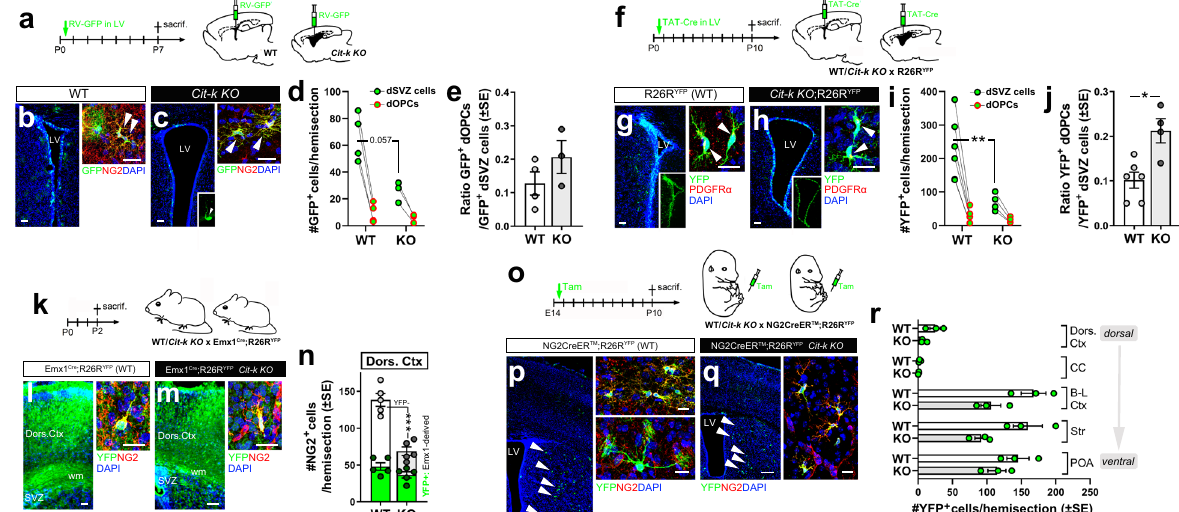
Fig. 3 Lineage-tracing approaches show that dorsal oligodendrogenesis is preserved in Cit-k KO mouse forebrain. a RV-based lineage-tracing approach. b , c ) Oligodendroglial cells (NG2 + , red) in P7 WT ( b right) or Cit-k KO ( c right) mouse dorsal cortices derived from VZ/SVZ precursors (GFP + , green) targeted by the RV ( b left, c left). White arrowheads in b right and c right indicate NG2 + OPCs. d Absolute numbers/hemisection of RV-targeted (GFP + ) cells in the dorsal SVZ (dSVZ; WT n = 4, KO n = 3; two-tailed Mann – Whitney U-test, P = 0.057) and of their OPC (GFP + /NG2 + ) progeny in the dorsal cortex (dOPCs; WT n = 4, KO n = 3; two-tailed Mann – Whitney U-test, n.s.). e Ratio between the number of GFP + /NG2 + cells in the dorsal cortex (dOPCs) and the number GFP + dSVZ precursors/hemisection (WT n = 4, KO n = 3; two-tailed Mann – Whitney U-test, n.s.). f TAT-Cre-based lineage- tracing approach. ( g left, h left) Recombined (YFP + , green) VZ/SVZ precursors in WT (R26R YFP ; g left) and Cit-k KO ( Cit-k KO; R26R YFP ; h left) mice. ( g right, h right) OPC (PDGFR α + , red) progeny (YFP + , green) in the dorsal cortex of WT ( g right) and Cit-k KO ( h right) mice. White arrowheads in g right and h right indicate PDGFR α + OPCs. i Absolute numbers/hemisection of recombined (YFP + ) cells in the dorsal SVZ (dSVZ; WT n = 6, KO n = 4; two- tailed Mann – Whitney U-test, P = 0.0095) and of their OPC (YFP + / PDGFR α + ) progeny in the dorsal cortex (dOPCs, WT n = 6, KO n = 4; two-tailed Mann – Whitney U-test, n.s.). j Ratio between the number of YFP + /NG2 + cells in the dorsal cortex (dOPCs) and the number YFP + dSVZ progenitors/ hemisection (WT n = 6, KO n = 4; two-tailed Mann – Whitney U-test, P = 0.0143). k Emx1 Cre ;R26R YFP mouse-based lineage-tracing approach. l , m Progeny (YFP + , green) of Emx1-expressing progenitors in the dorsal cortex and subcortical white matter of WT (Emx1 Cre ;R26R YFP ; l left) and Cit-k KO (Emx1 Cre ;R26R YFP Cit-k KO ; m left) mice. ( l right, m right) Oligodendroglial (NG2 + , red) progeny (YFP + , green) in the dorsal cortex of WT ( l right) and Cit- k KO ( m right) mice. n Quanti fi cation of NG2 + cells positive or negative for YFP in the dorsal cortex ( n = 5 each; two-tailed Unpaired t -test, YFP + : n.s, t(8) = 1.732; YFP-negative: P < 0.0001, t(8) = 9.878). o NG2CreER TM ;R26R YFP mouse-based lineage-tracing approach. p , q Progeny (YFP + , green) of NG2-expressing progenitors targeted at E14 in the striatum of P10 WT (NG2CreER TM ;R26R YFP ; p ) and Cit-k KO (NG2-CreER TM ;R26R YFP Cit-k KO ; q ) mice (NG2 in red). White arrowheads in p and q indicate YFP + cells in the striatum. r Mean absolute number/hemisection of YFP + /NG2 + cells in distinct forebrain regions at P10 in WT and KO (n = 3 each, two-tailed Mann – Whitney U-test, n.s. in all regions). In e , j , n , r ) data are mean ± SE. In d , i lines connect paired samples (i.e., dSVZ cell and dOPC values of the same mouse). DAPI (blue) in b , c , g , h , l , m , p , q counterstains cell nuclei. Scale bars: 20 µ m in b right, c right, g right, h right, l right, m right; 100 µ m in b left, c left, g left, h left, l left, m left, 200 µ m in p left, q left; 10 µ m in p right, q right. B-L Ctx baso-lateral cortex, CC corpus callosum, Dors. Ctx. dorsal cortex, dSVZ dorsal subventricular zone, GFP green fl uorescent protein, LV lateral ventricle, P postnatal day, POA preoptica area, RV retrovirus, sacrif. sacri fi ce, Str striatum, WT wild-type, wm white matter, YFP yellow fl uorescent protein. *** P < 0.001; ** P < 0.01, * P < 0.05. Source data are provided as a Source Data fi